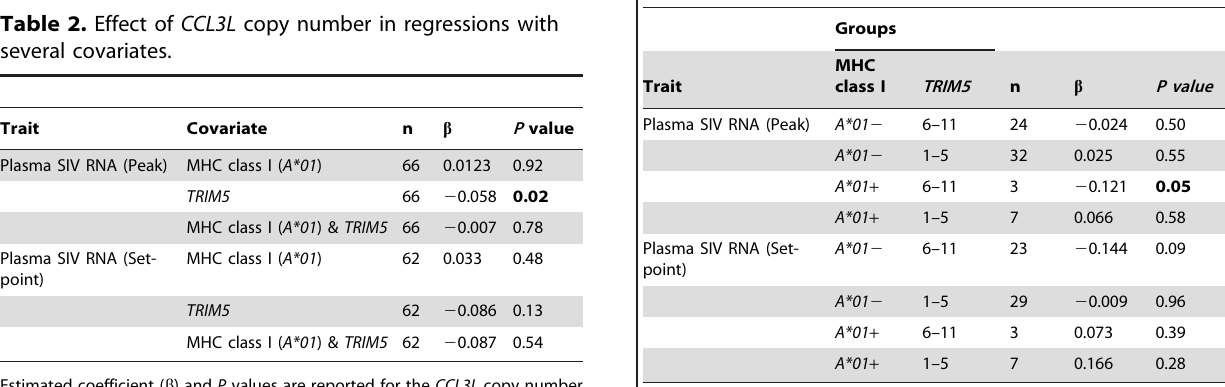
Table 2. Effect of CCL3L copy number in regressions with several covariates.